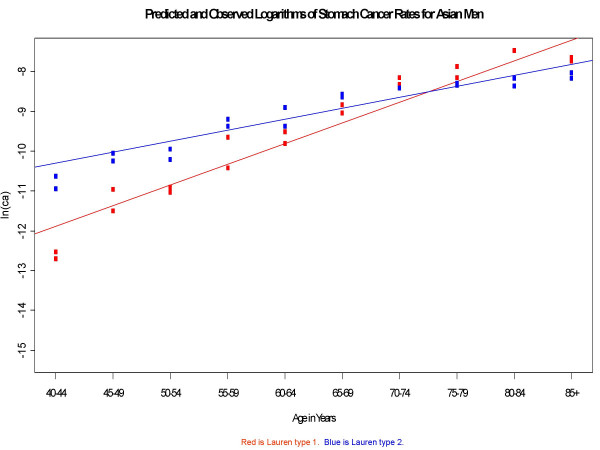
Plot of the natural logarithms of cancer rates, denoted as ln(ca), as a function of age in years for Asian men. Red references Lauren type 1 gastric cancer. Blue references Lauren type 2 gastric cancer. Lines represent predicted values. [see Additional file 1]